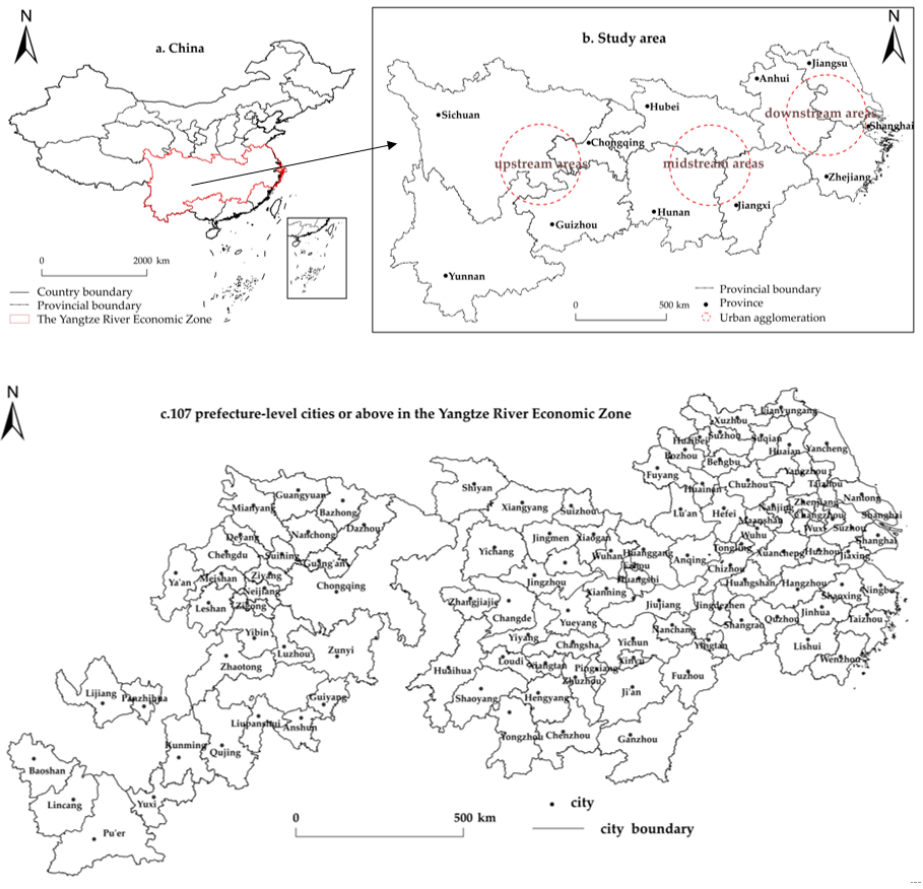
Figure 2. The spatial scope of the Yangtze River Economic Zone in China.